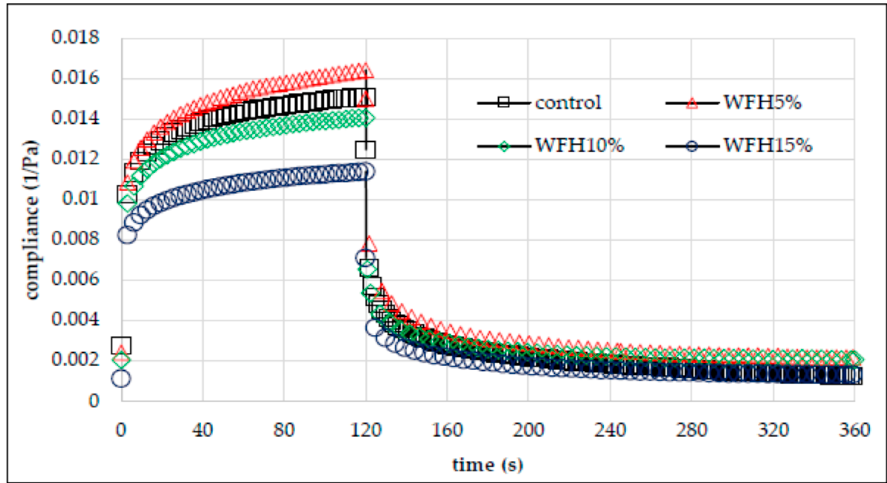
Figure 7. Creep and recovery curves of wheat flour gel and samples with hazelnuts addition .